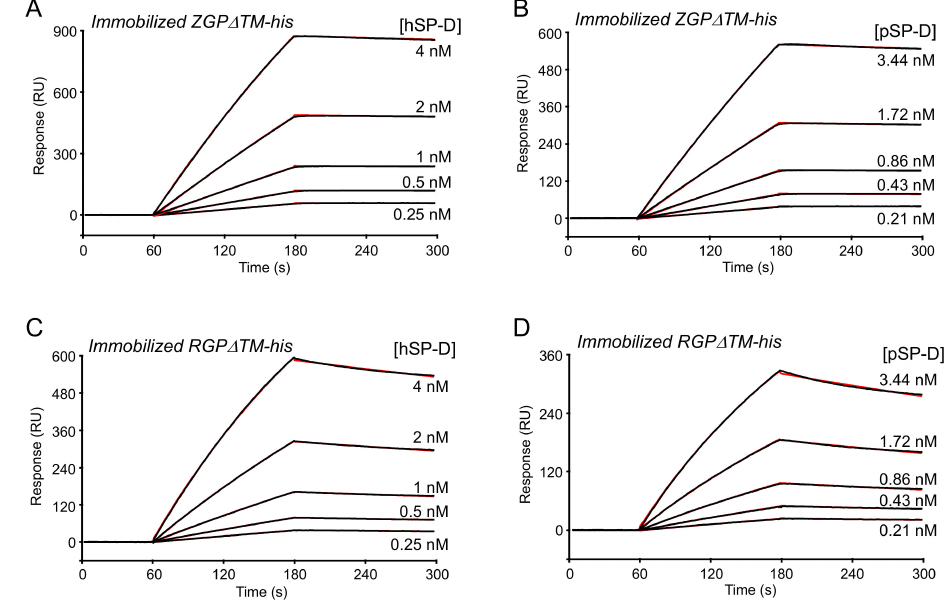
Figure 3. SPR analyses of the interaction of human and porcine SP-D with immobilized baculovirus-expressed GP ∆ TM from Zaïre (ZGP ∆ TM-b) and Reston (RGP ∆ TM-b) ebolaviruses. ( A , B ) Forty microliters of hSP-D and pSP-D were injected at the indicated concentrations over immobilized ZGP ∆ TM-b (4800 RU) in 50 mM triethanolamine-HCl, 145 mM NaCl, 2 mM CaCl 2 , 0.005% surfactant P20, and pH 7.4. ( C , D ) hSP-D and pSP-D were injected over immobilized RGP ∆ TM-b (2,700 RU) in the same buffer. (A–D) Fits shown as red lines were obtained by global fitting of the data using a 1:1 Langmuir binding model. The specific binding signals were obtained by subtracting the background signal over a reference surface obtained through performing the immobilization step without added protein. Each kinetic analysis shown is representative of two independent experiments performed on separate sensor